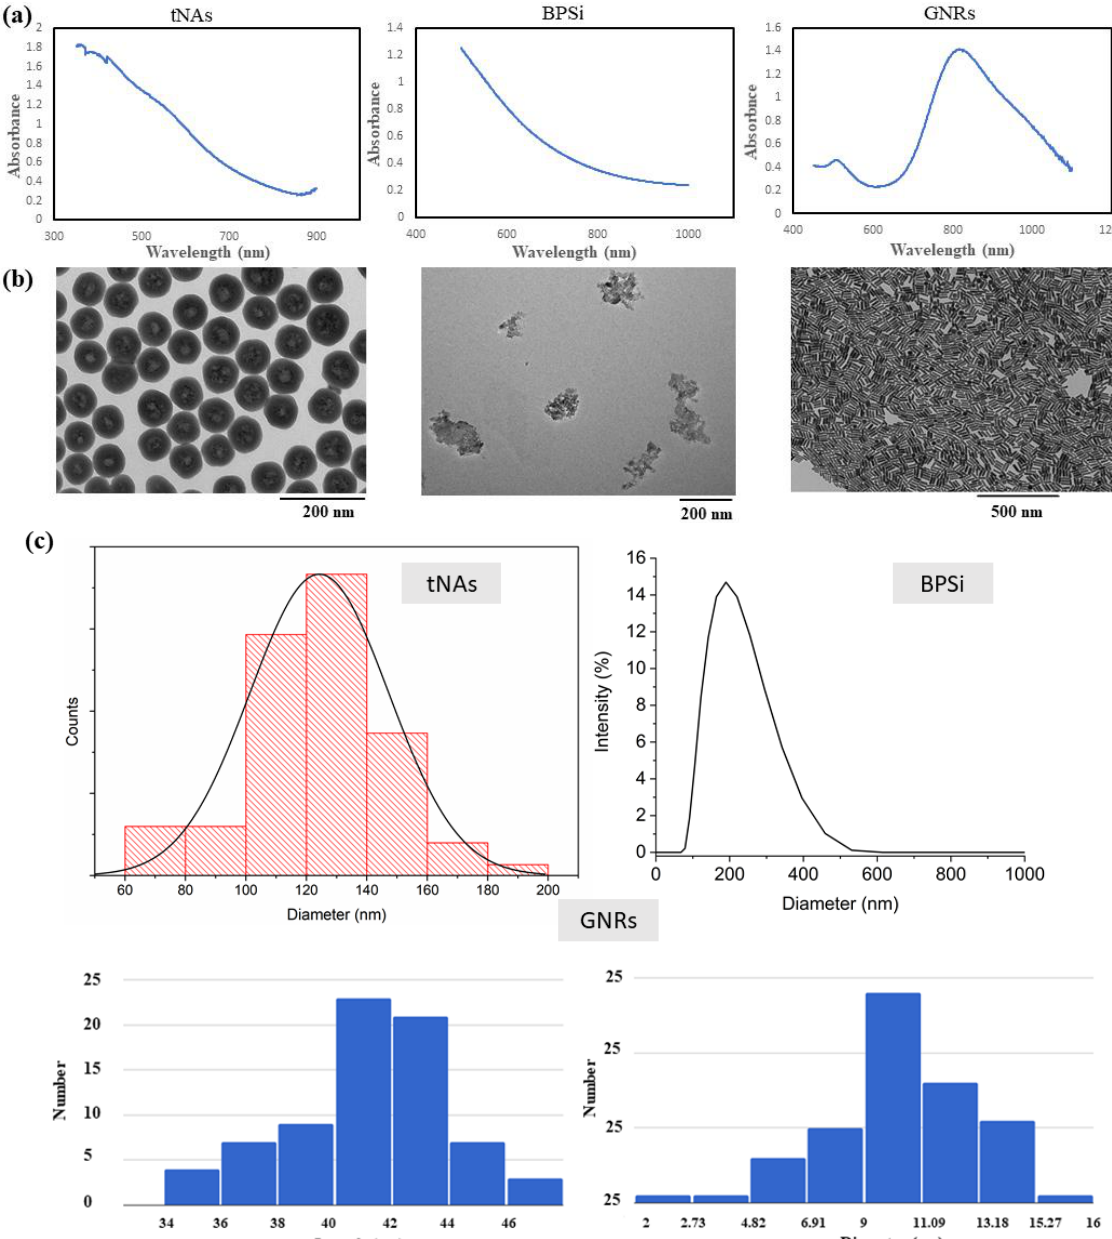
Figure 1. ( a ) Absorbance spectra, ( b ) TEM images and ( c ) size distribution graph for the tNAs, BPSi and